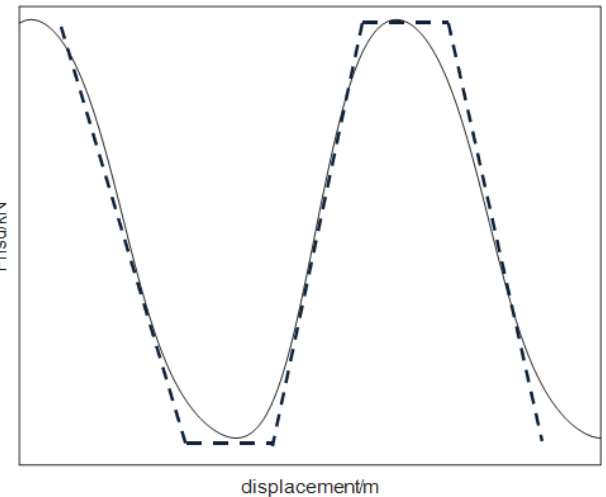
Figure 19. Simplified mechanical model of the negative-stiffness device.